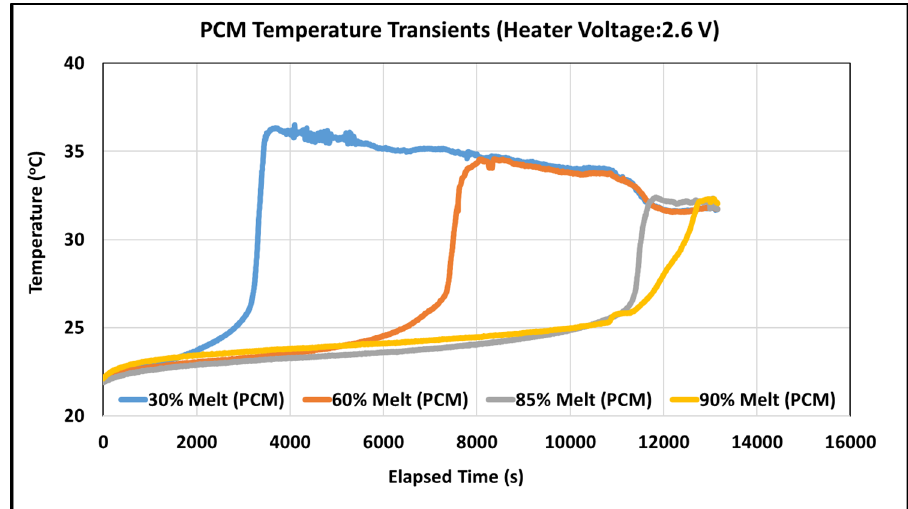
Figure 4. Plot of transient PCM-temperature data for heater input voltage of 2.6 V (1.4 W power input).